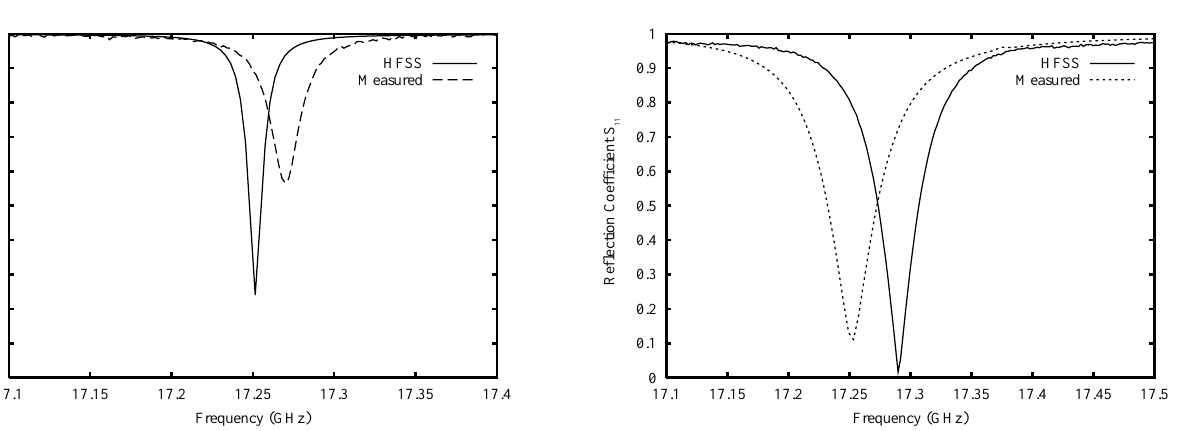
FIG. 5. Vertex coupling scheme with six rods removed and two rods partially withdrawn: frequency dependence of the measured reflectivity, S 11 (dotted line) and HFSS simulations (solid